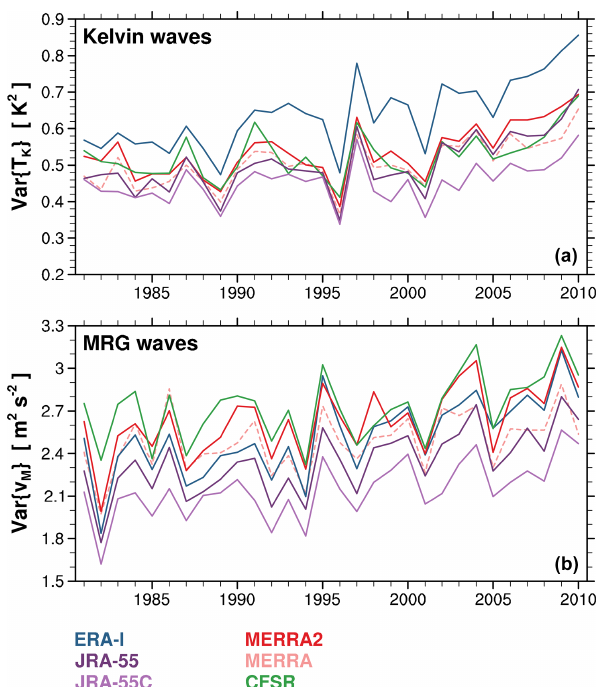
Figure 6. Annual-mean time series of variances of (a) T Kelvin and (b) v MRG at 100hPa averaged over 15 ◦ N–15 ◦ S. The MERRA re- sults are from the standard-level datasets (dashed lines), and the oth- ers from the model-level datasets (solid lines).